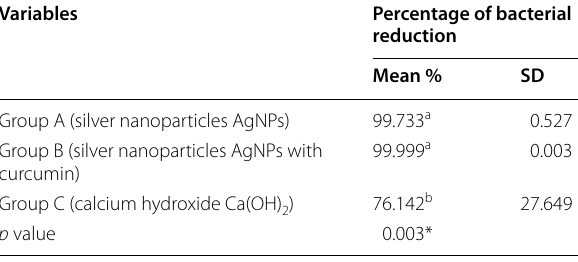
Means with different lower case letters in the same column related to statistically significance difference * Significant ( p < 0.05)